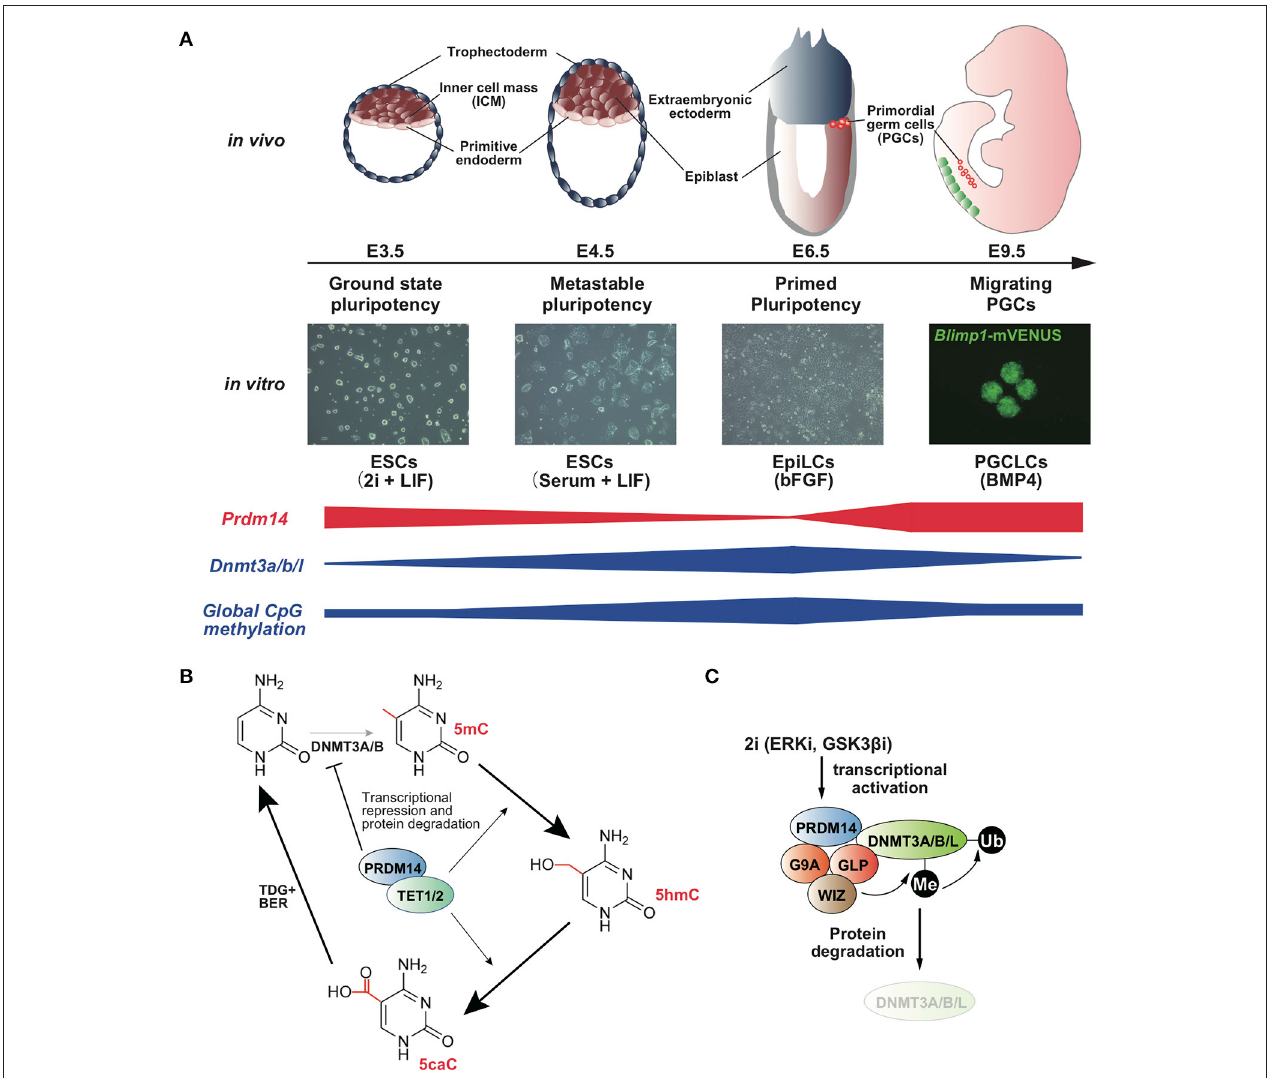
FIGURE 1 | (A) Prdm14 expression negatively correlates with global CpG methylation level in the states of pluripotency and PGC development (Yamaji et al., 2008, 2013). (B) Model for the acceleration of TET-TDG-BER-mediated DNA demethylation by PRDM14 (Okashita et al., 2014). (C) Model for protein degradation of DNMT3A/B/L by PRDM14 (Sim et al.,